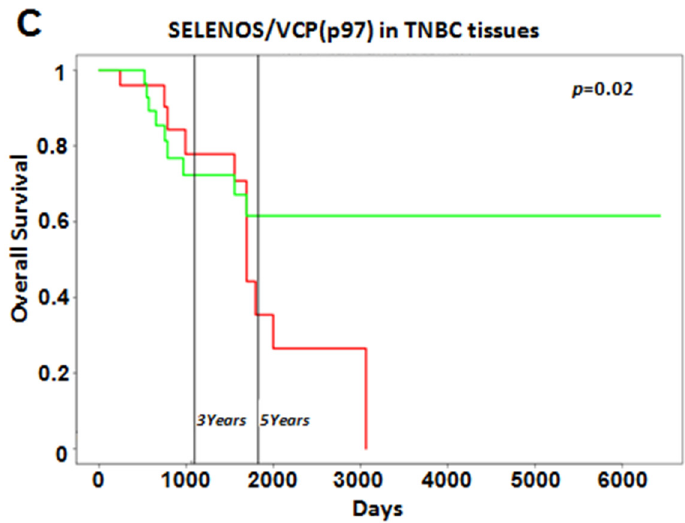
Figure 6. ( A ) VCP/p97 and SELENOS gene expression reported as transcript per million (TPM) in the TCGA dataset. We report the p -values indicating the statistically significant difference between normal and TNBC samples. ( B ) Pearson correlation between SELENOS and VCP/p97 expression in TNBC samples from the TCGA dataset. Correlation coefficient (R) and p -value are reported. ( C ) Kaplan–Mayer curves showing the correlations between overall survival (expressed in percentage) and the combined gene expression of SELENOS/VCP(p97) in TNBC tissues in the TCGA dataset, by PROGgeneV2 online tool. High and low expression of SELENOS/VCP(p97) are reported by the red and green curves, respectively.